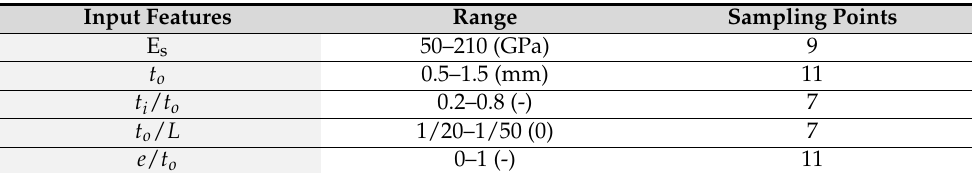
Table 1. First-scale S 1 and second-scale S 2 metamaterial design parameter range used for the creation of training datasets for multiscale square, honeycomb and star re-entrant lattice patterns. Input Features Range Sampling Points